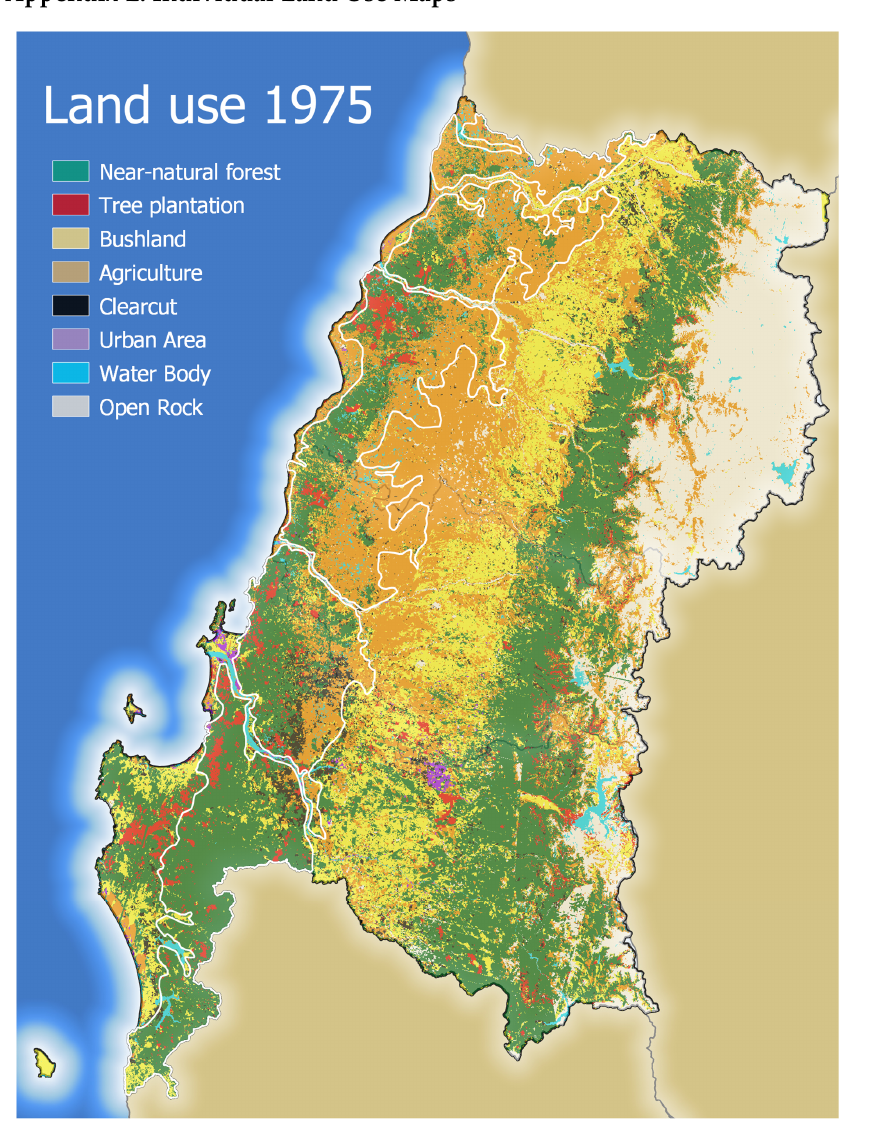
Figure A1. Land use map of study site in 1975.